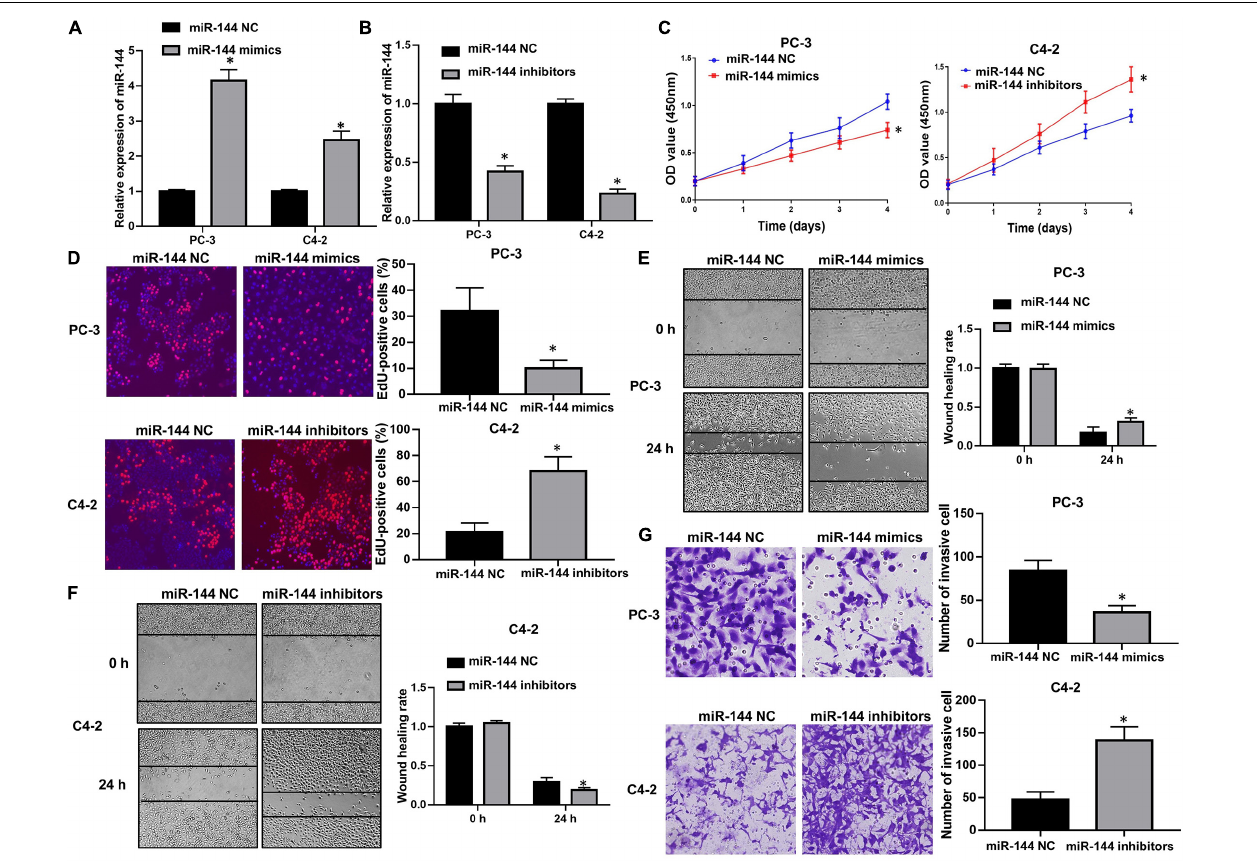
FIGURE 7 | miR-144 inhibited CRPC cell proliferation and cell invasion. (A) Transfection efficacy of miR-144 mimics in CRPC cells, as detected by RT-QPCR; (B) Transfection efficacy of miR-144 inhibitors in CRPC cells, as detected by RT-QPCR; (C) The effects of miR-144 mimics or inhibitors on the proliferation of PC-3 and C4-2 cells, as detected by CCK-8 assay; (D) The effects of miR-144 on the proliferation of PC-3 and C4-2 cells, as detected by EdU assay; (E) The effects of miR-144 mimics on the migration of PC-3 cells, as detected by wound healing assay; (F) The effects of miR-144 inhibitors on the migration of C4-2 cells, as detected by wound healing assay; (G) The effects of miR-144 mimics or inhibitors on the invasion of PC-3 and C4-2 cells, as detected by transwell assay; Data are expressed as the mean ± SE . * P < 0.05, ns, not significant. The representative results of three independent experiments are